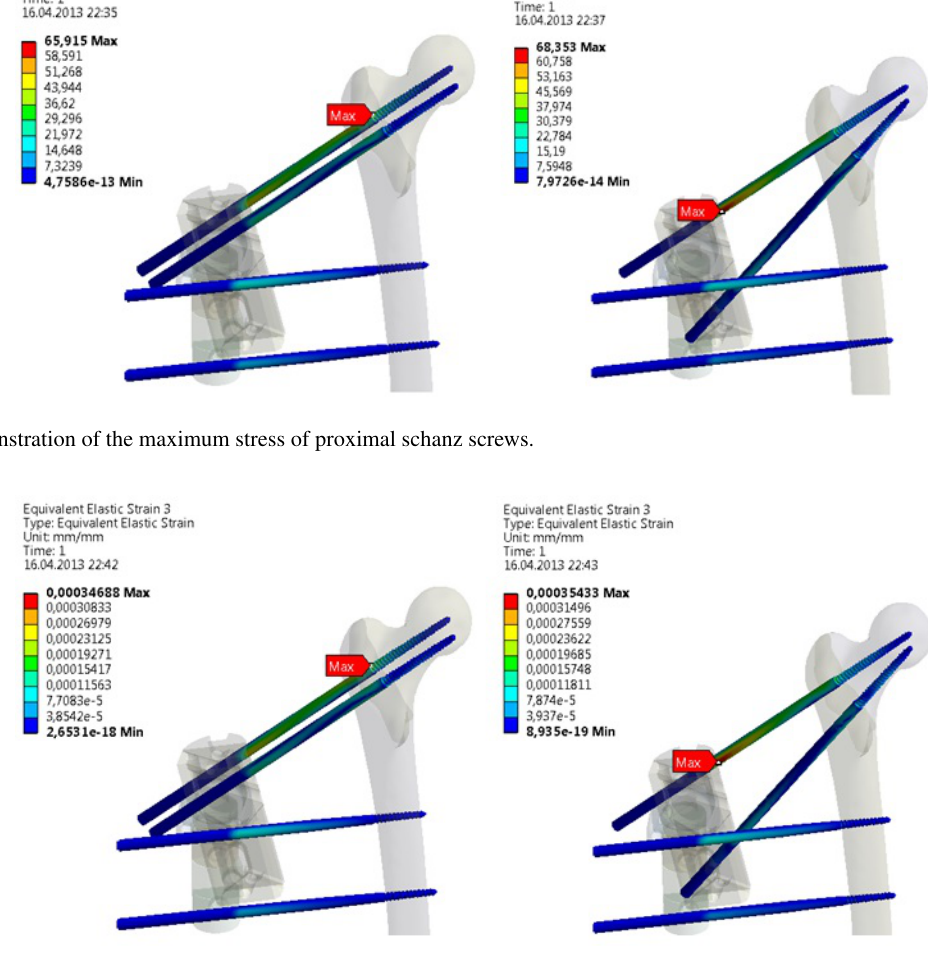
Figure 6. Demonstration of the maximum strain of proximal schanz